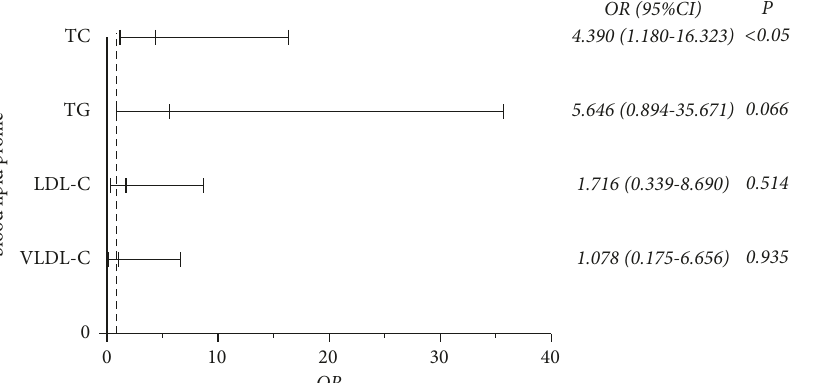
Figure 2: Multivariate logistic regression analysis between blood lipid profiles and LN Abbreviations: TC: total cholesterol; TG: triglyceride; LDL-C: low-density lipoprotein cholesterol; VLDL-C: very low-density lipoprotein